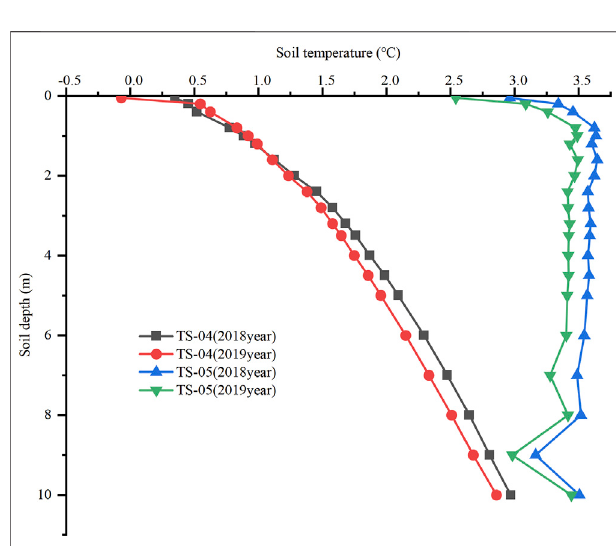
FIGURE 12 | Envelope of soil temperature under different vegetation